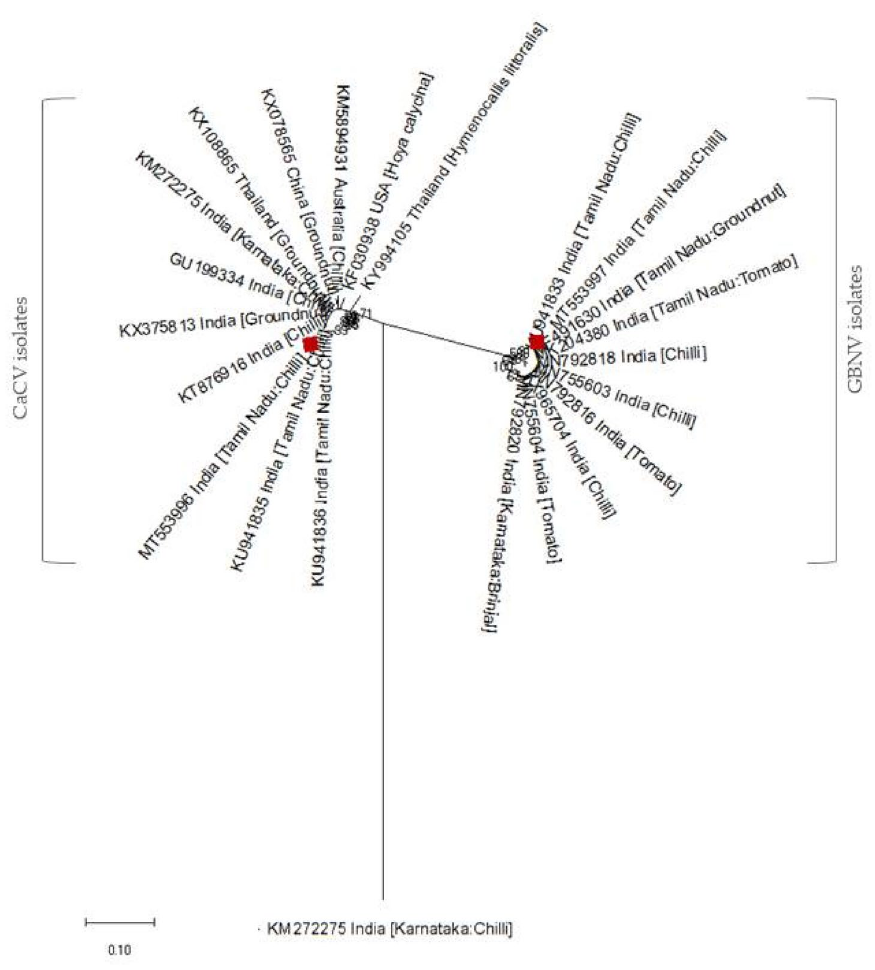
Figure 5. Phylogenetic relationship of TN CaCV and TN GBNV isolates with other isolates based on RdRp segment. Phylogenetic tree generated using MEGA 7 software using Neighbor joining tree method with 1000 replicates and CMV (KM272278) isolate used as out